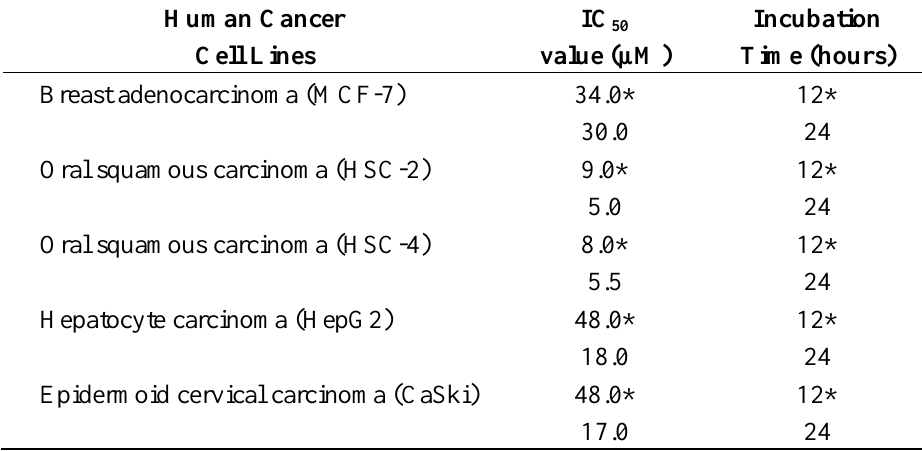
Table 1. IC values of ACA in various human cancer cell lines at different incubation periods. 50